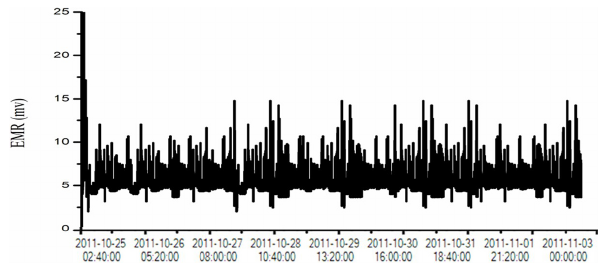
Figure 7. Dynamic variation of EMR generated from regions in which no damage